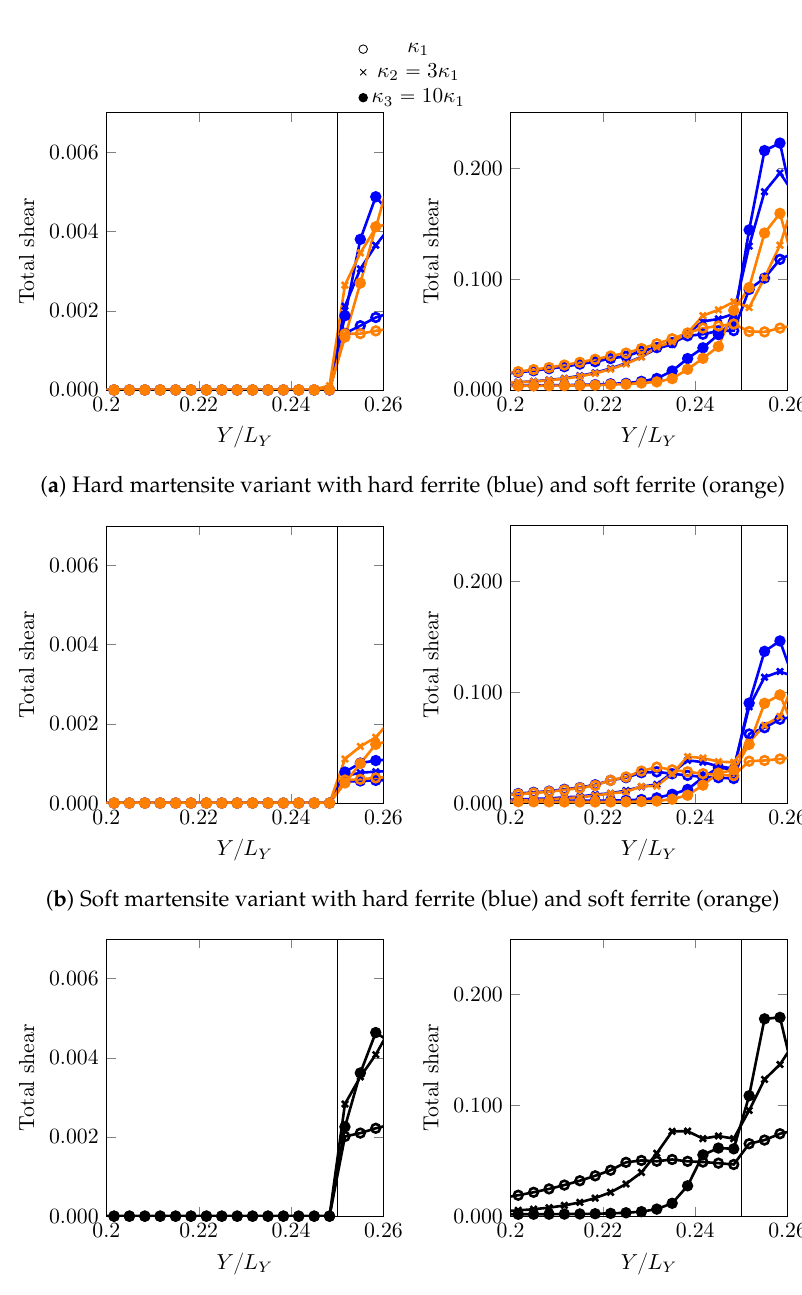
L X /2 N X , ahead of the curved phase boundary −